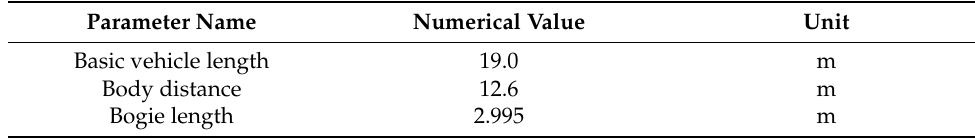
Table 2. Dimensional parameters of subway type B car.